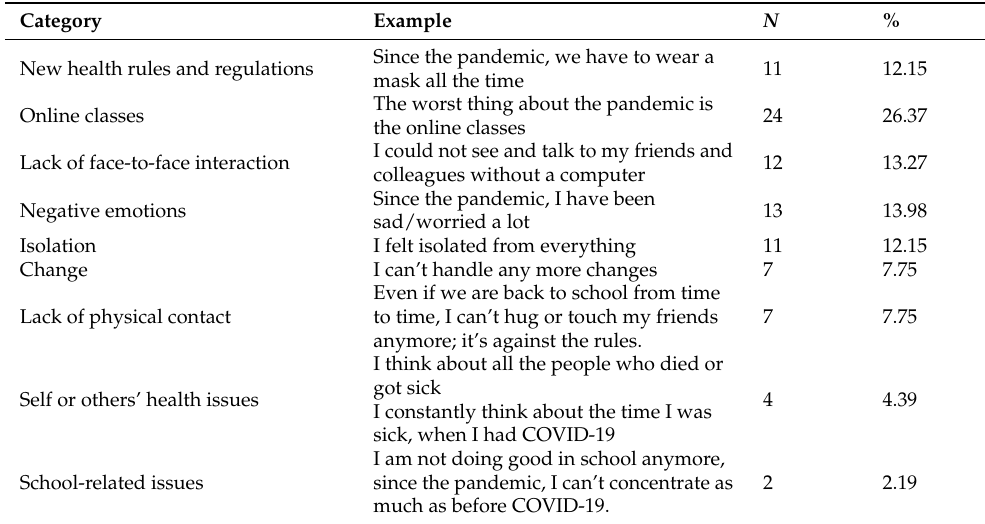
Table 3. Source of the self-perceived adverse effects of the COVID-19